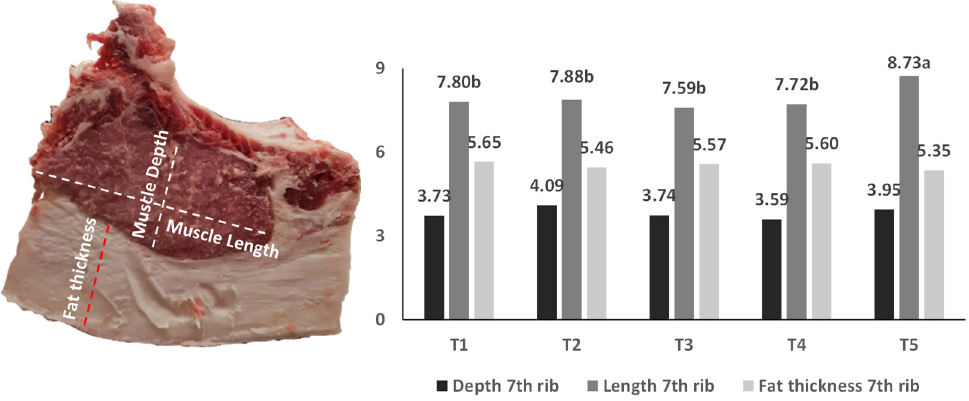
Figure 2. Measurements on Longissimus thoracis et lumborum muscle the of Bísaro carcass at the 7th ribs of the loin joint. Mean values with different lowercase letters within the same treatment are significantly different ( p < 0.05). Mean values without letters have no significant differences ( p > 0.05). T1—Basic diet and commercial feed; T2—Basic diet + 10% crude olive cake; T3—Basic diet + 10% olive cake, two phases; T4—Basic diet + 10% exhausted olive cake; T5—Basic diet + 10% exhausted olive cake + 1% olive